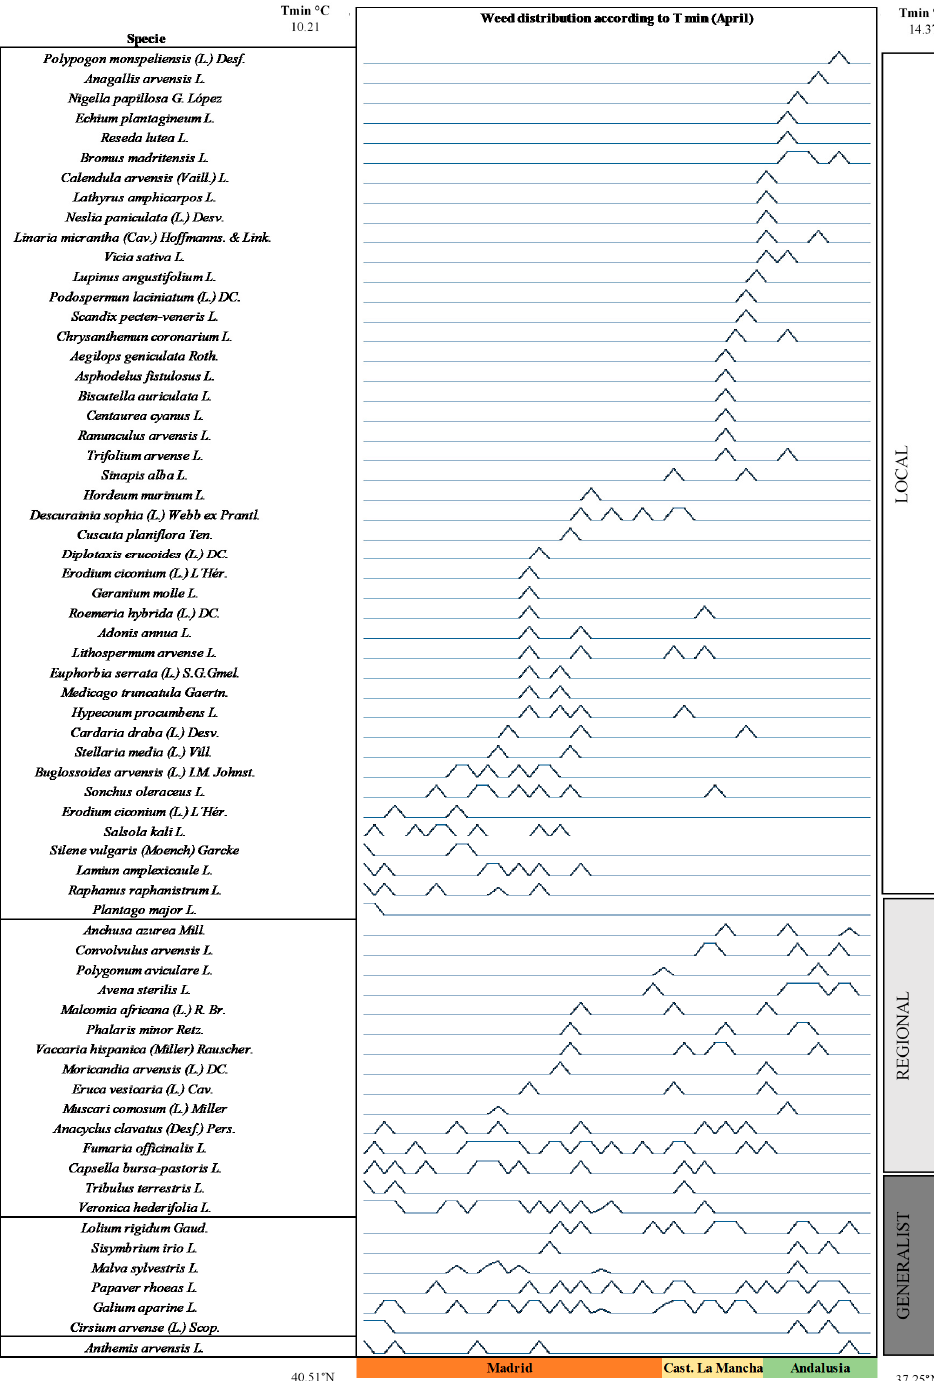
Figure 3. Graphical pattern of arable weeds distribution according to the Tmin in April.